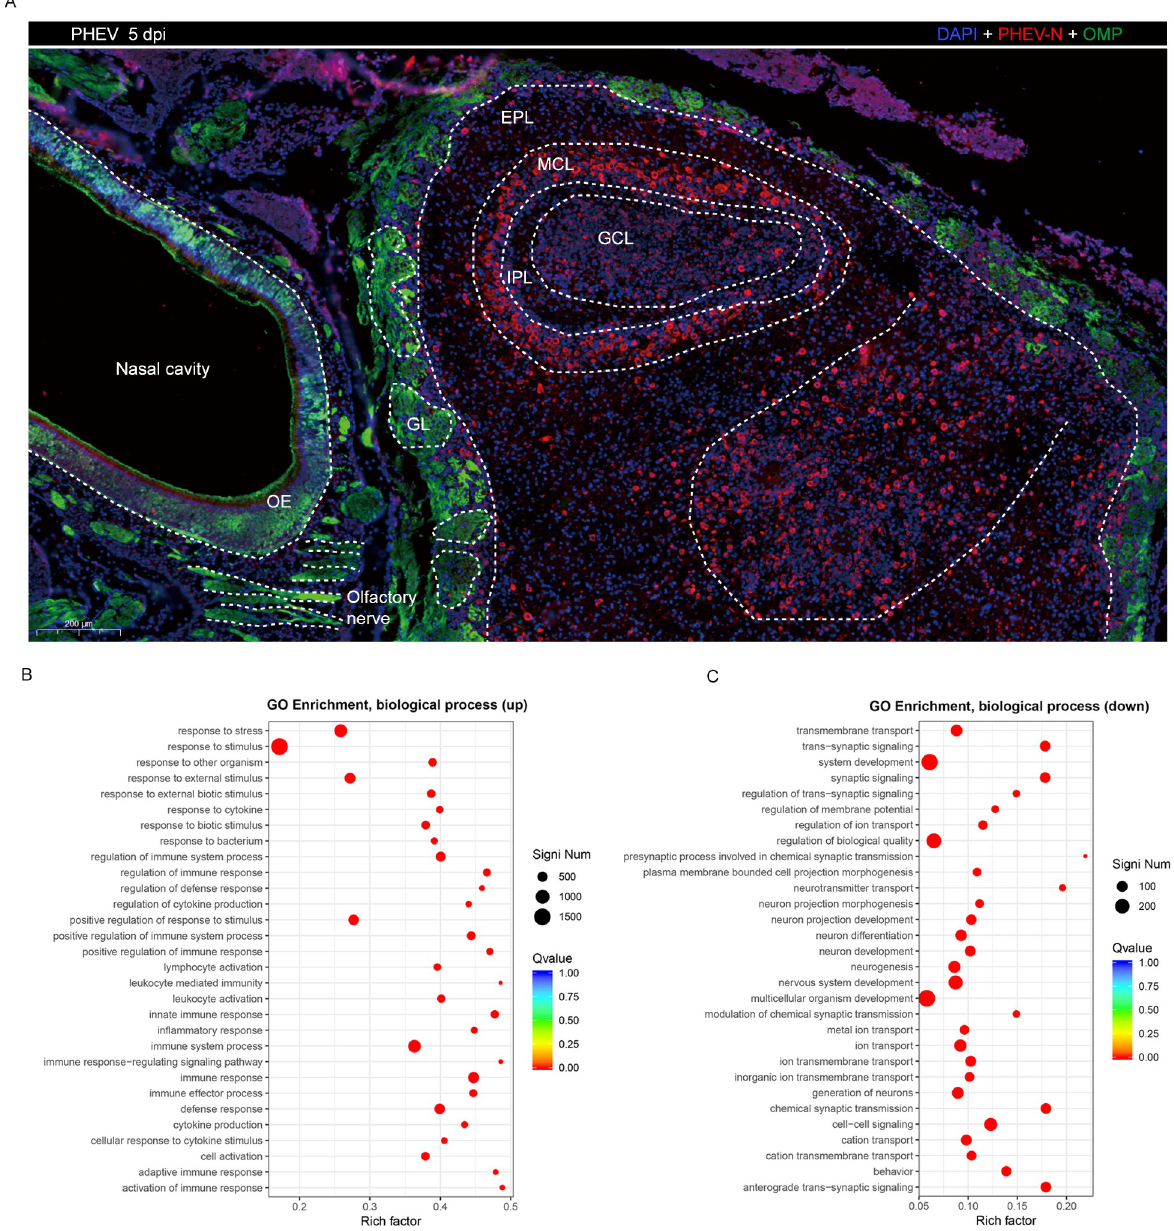
Fig 11. Differentially expressed genes screened in the OB of PHEV-infected mice. The 3w BALB/c mice were inoculated intranasally with 10 3.96 TCID 50 PHEV. (A) At 5 dpi, mice were euthanized and OB samples were collected for immunofluorescence staining with antibodies against OMP (green) and PHEV-N (red). PHEV-positive cells were widely distributed in the OB, especially in the MCL and GCL. GL, glomerular layer; EPL, external plexiform layer; MCL, mitral cell layer; IPL, internal plexiform layer; GCL, granular cell layer. (B-C) Differentially expressed genes in the OB of PHEV-infected mice at 5 dpi were analyzed by RNA-seq. Scatter plot of biological processes identified in the GO enrichment analysis. The vertical axis represents the functional annotation information, and the horizontal axis represents the Rich factor corresponding to the function. (Only the 30 most enriched KEGG and GO terms are plotted for the significantly differentially expressed gene set).